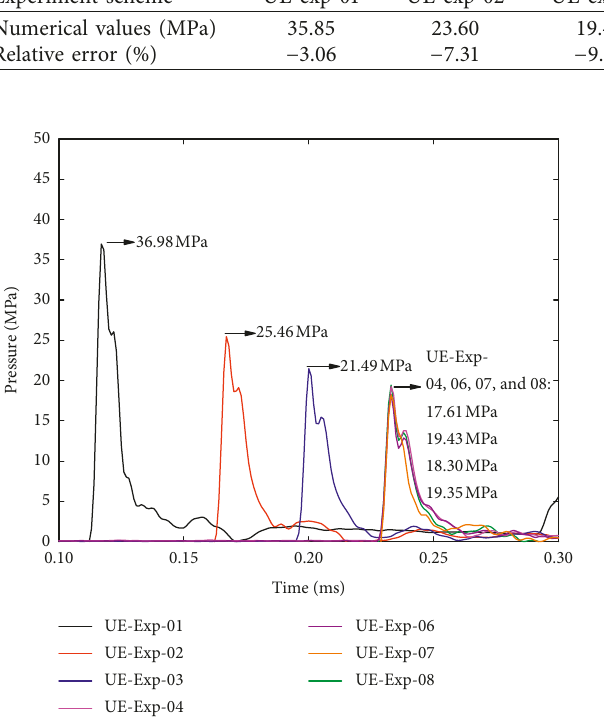
Figure 17: Pressure-time curves at different cases.